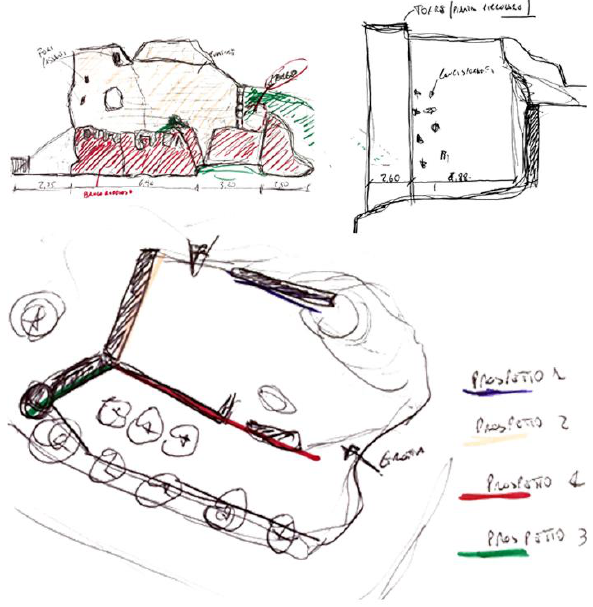
Figure 2. Sketches and functional diagrams of the ruins of the Assoro castle for the surveying planning